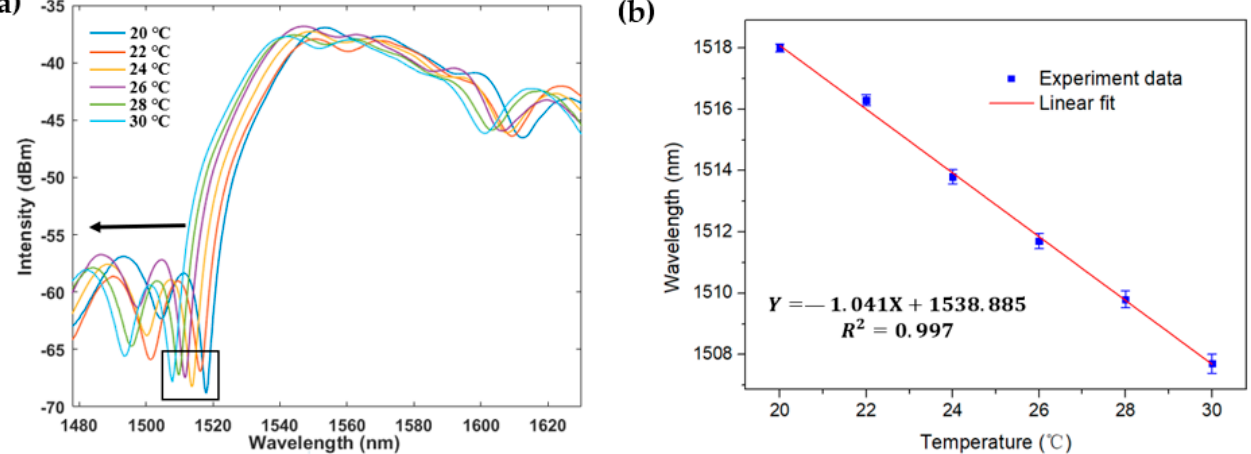
Figure 6. Temperature response of the LC filled HCF structure in ASE source. ( a ) Transmission spectra of temperature from 20 °C to 30 °C; ( b ) relationship between the resonant wavelength response and the temperature.